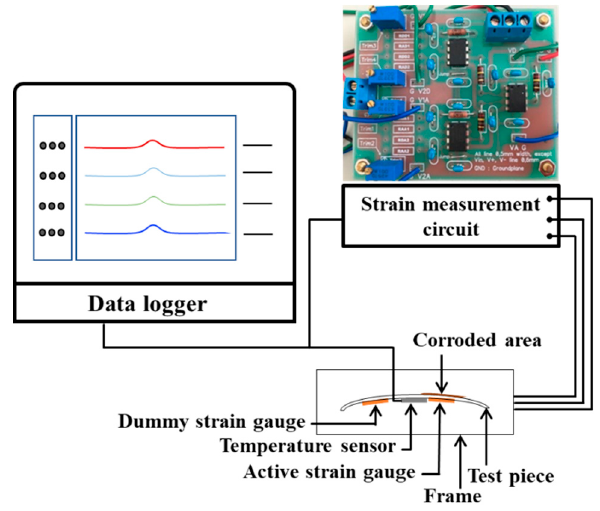
Figure 5. Experimental set-up of under dry-wet condition for ACSSM.